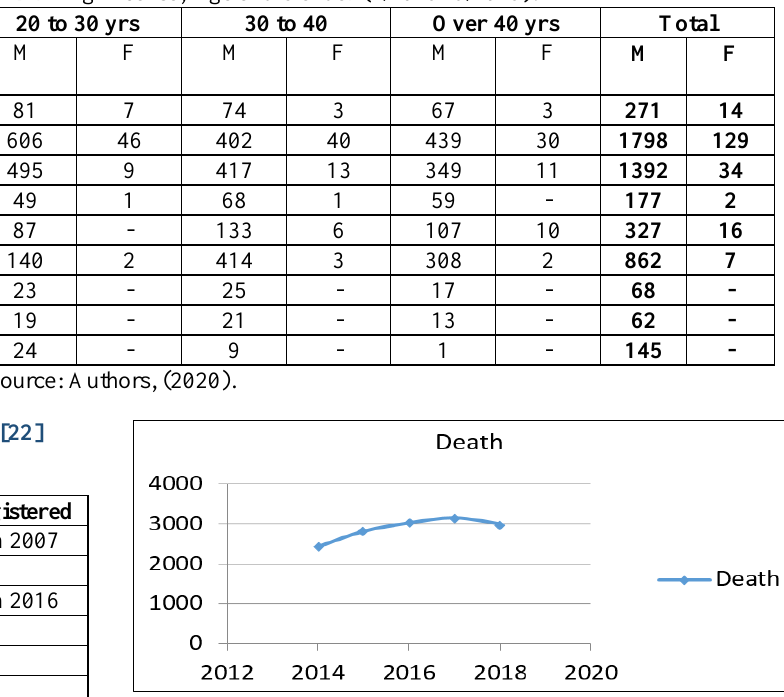
Figure 10: Road fatality over last 5 years